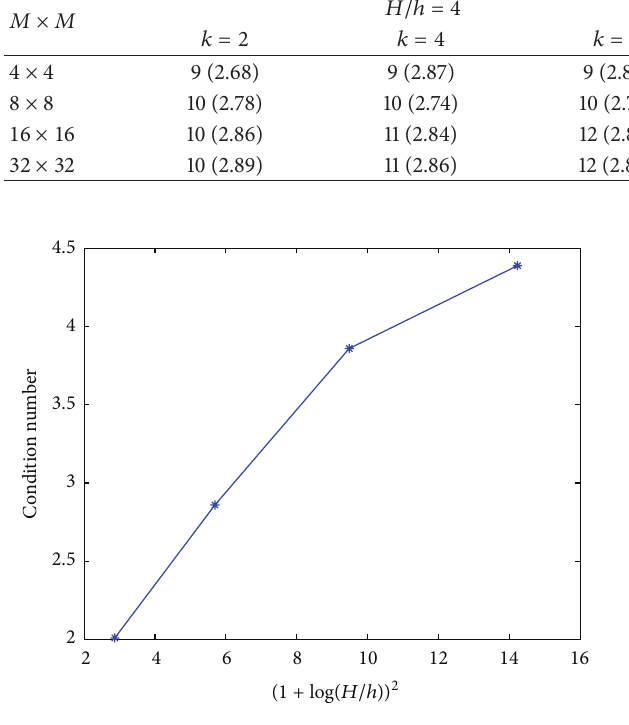
Figure 1: Plot of the condition numbers as the function of (1 + log (𝐻/ℎ)) 2